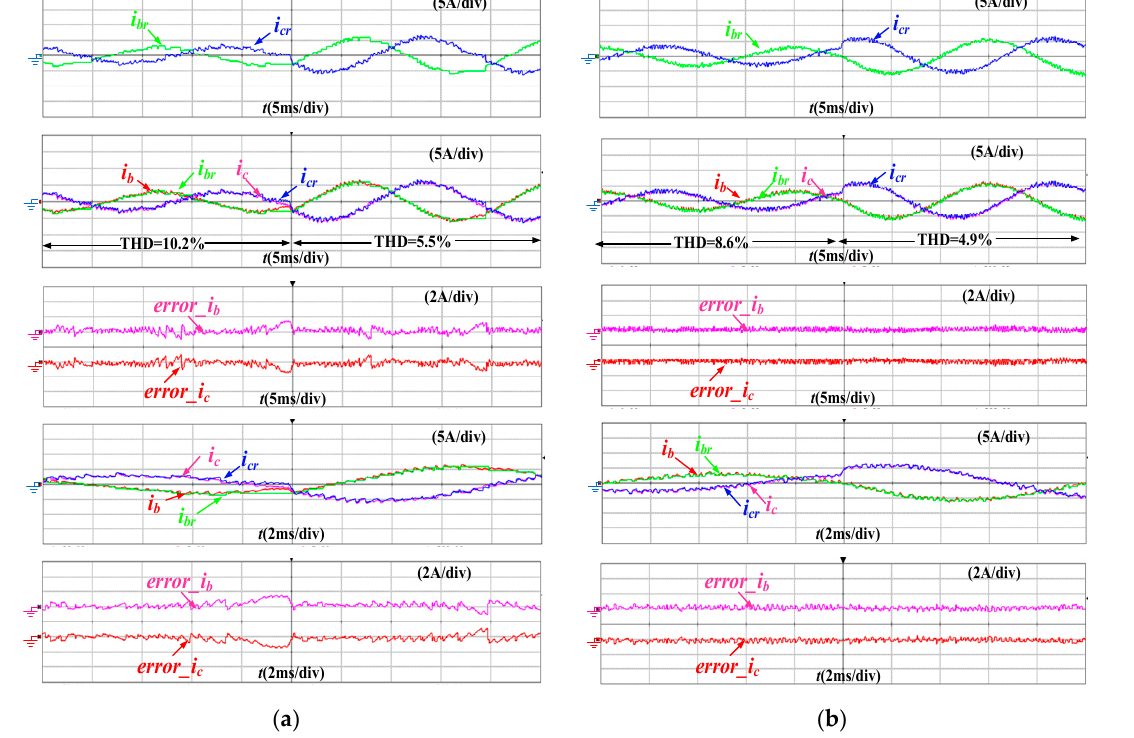
Figure 11. Current reconstruction when active power steps from 500 W to 1000 W (from top to bottom: reconstructed current of phases B and C i br , i cr ; reconstructed and actual current of phases B and C i br , i cr , i b , i c in 5 ms/div; errors between reconstructed and actual current of phases B and C error _ i b , error _ i c in 5 ms/div; reconstructed and actual current of phases B and C i br , i cr , i b , i c in 2 ms/div; errors between reconstructed and actual current of phases B and C error _ i b , error _ i c in 2 ms/div): ( a ) the traditional voltage selection; ( b ) the improved voltage selection method.